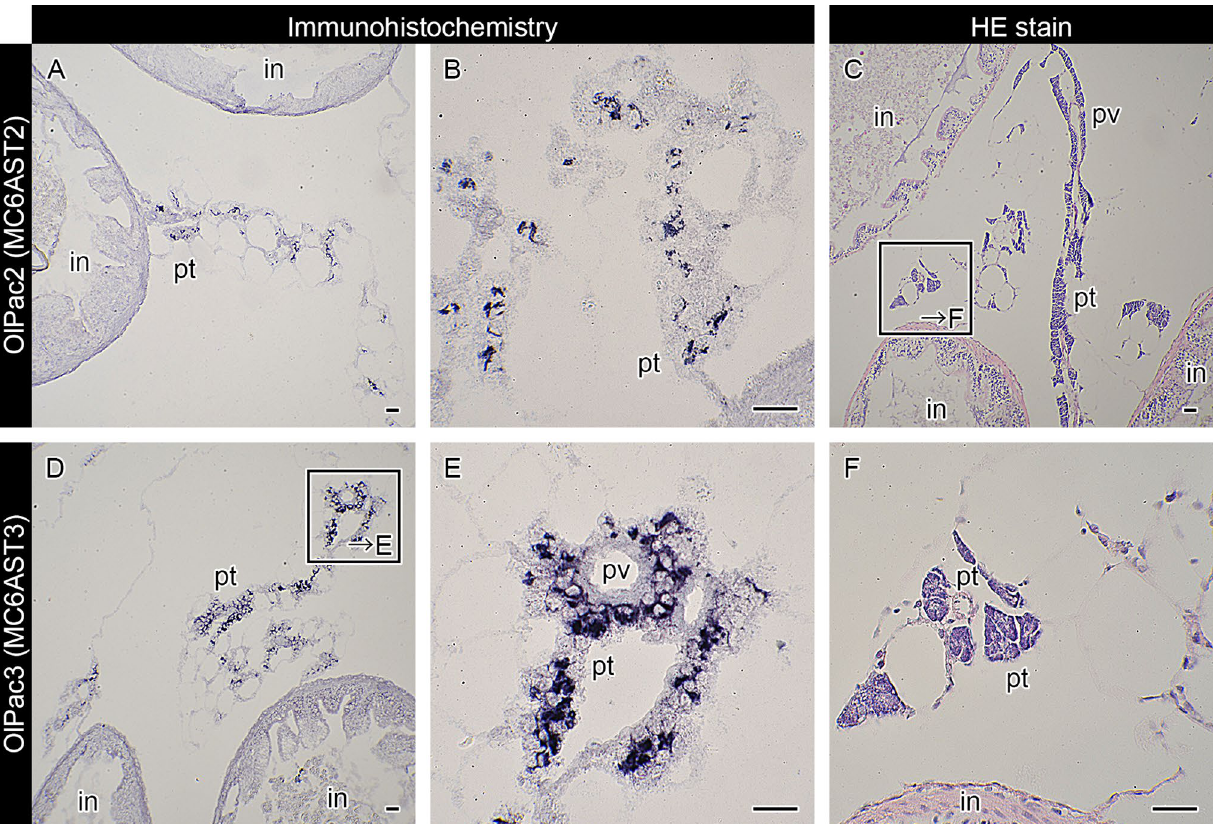
Figure 6. Localization of OlPac2 (MC6AST2) and OlPac3 (MC6AST3) in medaka. Organs were immunostained with anti-OlPac2 ( A , B ) or anti-OlPac3 antibody ( D , E ). The lettered boxes in ( C , D ) indicate sites of high magnification views shown in ( F , E ), respectively. Positive signals were stained purple. Organs were stained with hematoxylin–eosin ( C , F ) to identify the portal veins (pv). in, intestine; pt, pancreatic tissue; pv, portal veins. Scale bars: 20